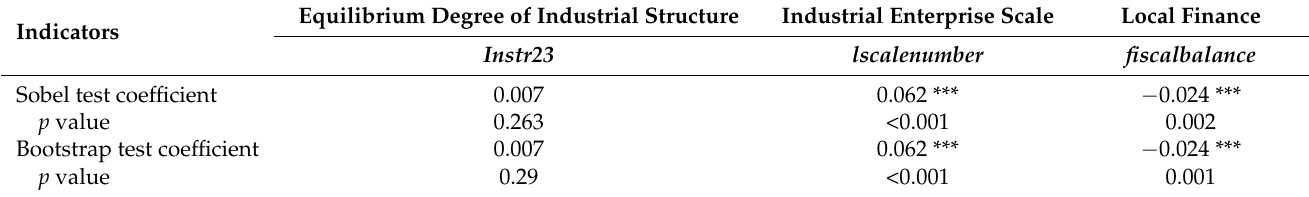
Table 8. Intermediary variable: Sobel and bootstrap test